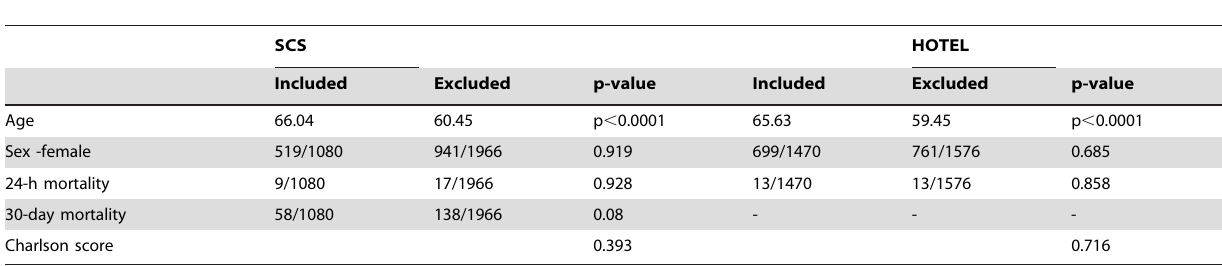
Table 4. Sources of selection bias in excluded